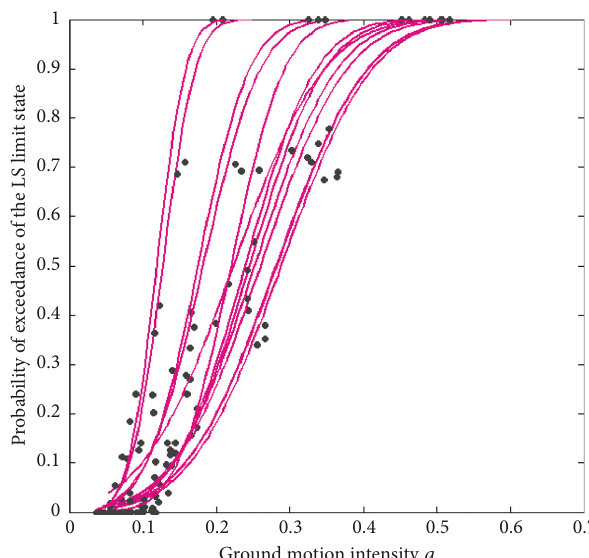
Figure 12: Fitted fragility curves for cases that could be structurally upgraded by partial retrofitting.